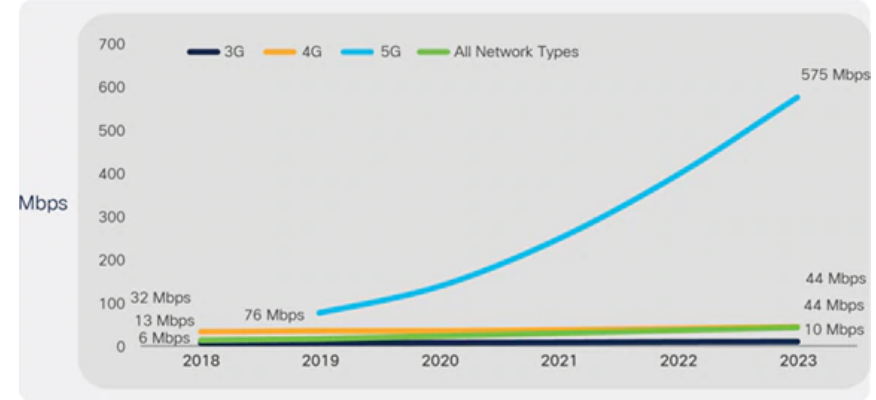
Figure 3. Global mobile device and connection growth